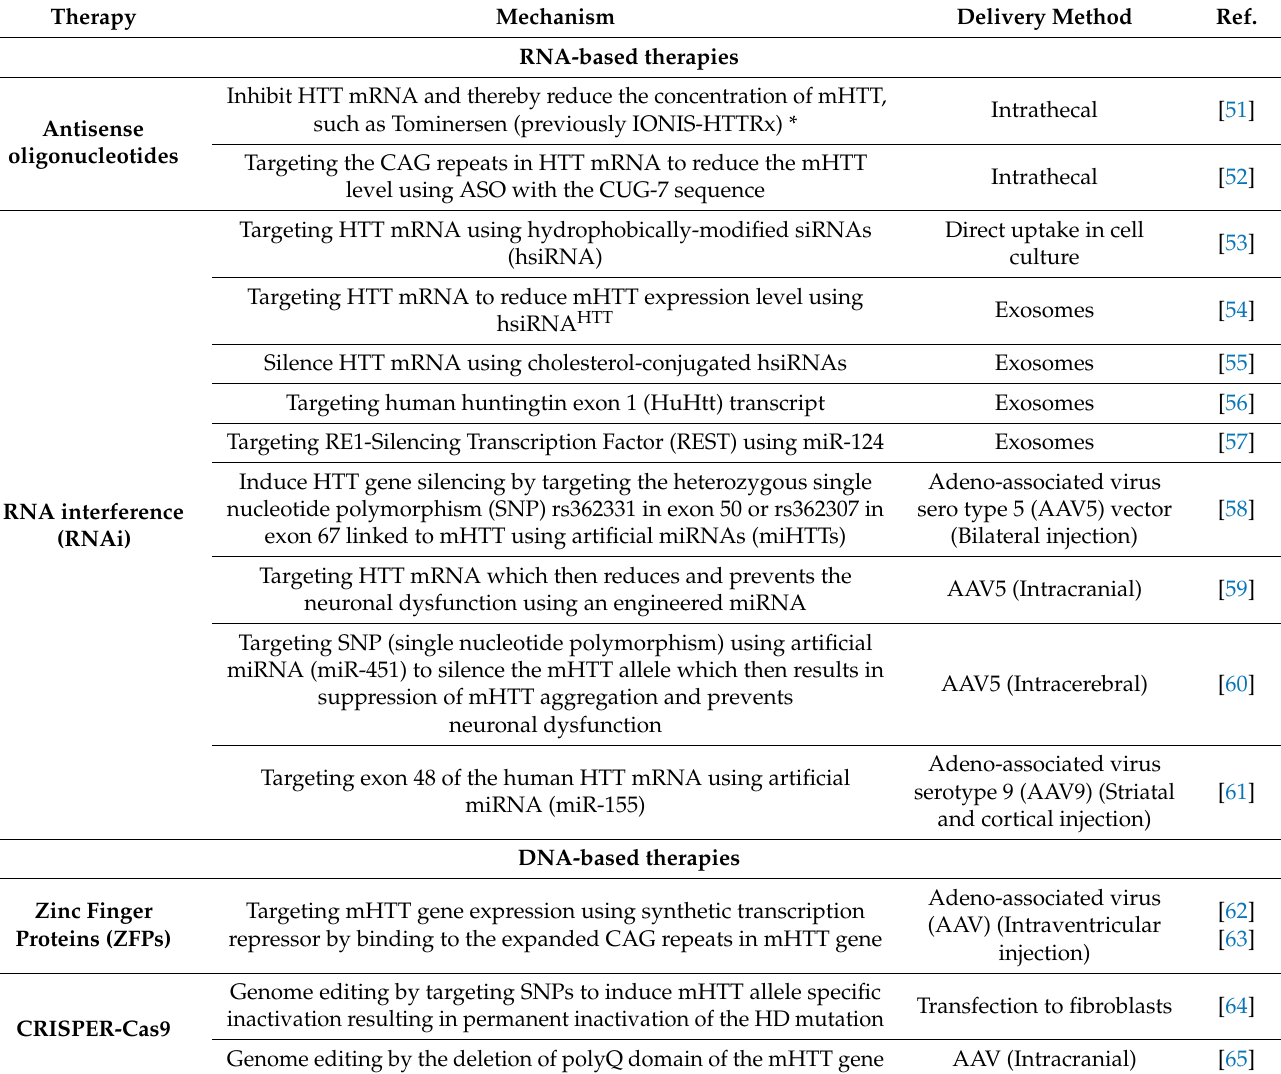
Table 1. DNA- and RNA-based strategies targeting mHTT production